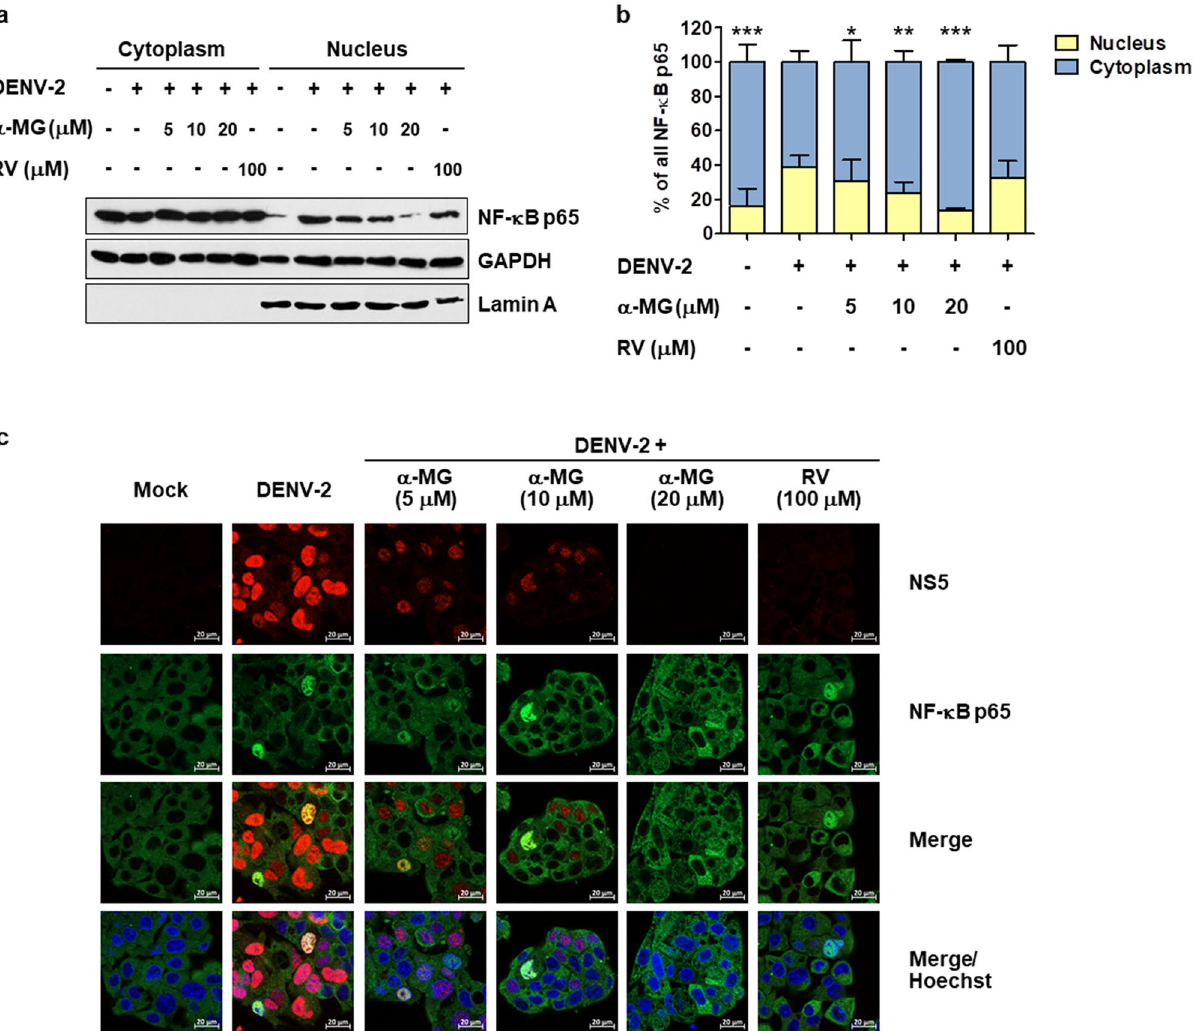
Figure 6. α-MG inhibits NF-κB nuclear translocation. HepG2 cells were infected with DENV-2 at a MOI of 5 and treated with 5, 10, or 20 μM of α-MG or 100 μM of RV. HepG2 cells that were not infected with DENV-2 were used as mock control. The cells were harvested at 24 h after treatment. Cytoplasmic and nuclear proteins were fractionated. ( a ) The expression of NF-κB p65 was determined by Western blotting using an anti-NF-κB p65 antibody. NF-κB p65 bands were scanned and quantified using ImageJ software. Lamin A was used as a protein marker of nuclear fraction. ( b ) The levels of NF-κB p65 were quantified, and the average values from three independent experiments were calculated after being normalized to the level of the GAPDH protein. The intracellular distribution of NF-κB p65 between the nucleus and cytoplasm was calculated from the levels of NF-κB p65 in the nucleus or cytoplasm divided by the total nuclear plus cytoplasmic levels of NF-κB p65. Two- way ANOVA and Bonferroni posttest were used to determine differences of NF-κB p65 levels between nuclear and cytoplasmic fractions and between treatment groups. ( c ) Immunofluorescence assay demonstrates the expression and intracellular localization of NF-κB p65 (green) and DENV NS5 (red). Hoechst stain was used for nuclear staining (blue). Images are representative of three independent